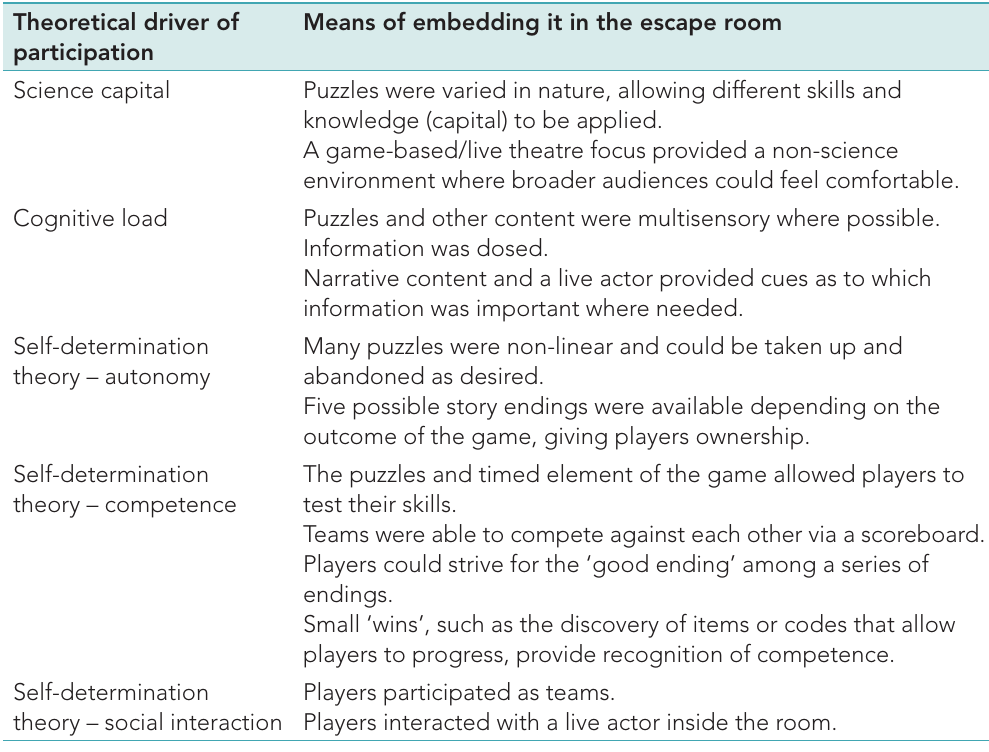
Table 1: Theoretical drivers of participation and the means of embedding them in the escape Malta escape room Theoretical driver of Means of embedding it in the escape room participation Science